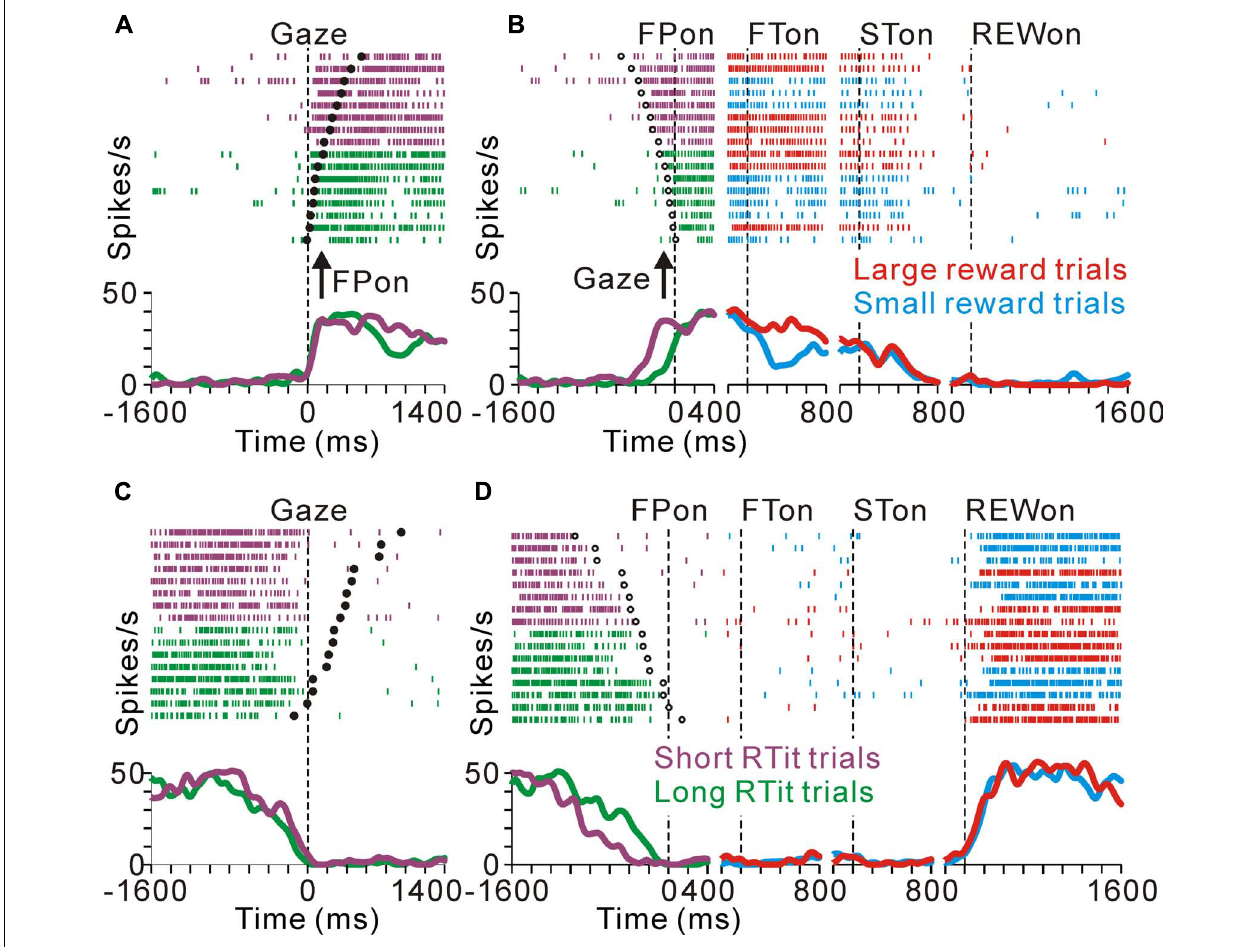
FIGURE 6 |Anticipatory behavior-related activity modulation of the tonic excitatory and suppressive neurons. Examples of neuronal activity during the same set of trials are shown.The rastergrams and spike density functions are aligned to the monkeys’ gaze shift to the center of the screen (A–C) and initial target appearance (B–D) .The trials are sorted by RTit.The filled and open circles indicate initial target appearance and gaze shift, respectively.The